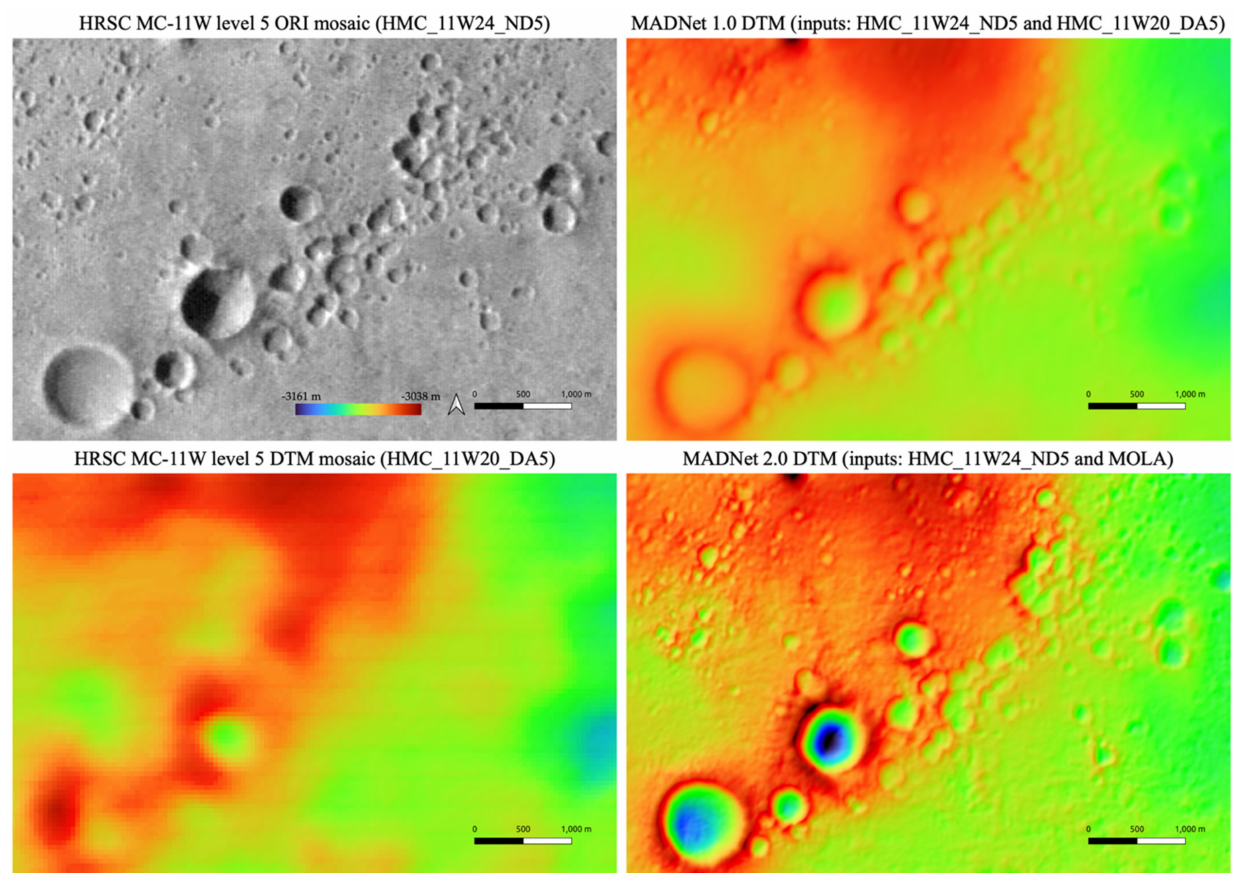
Figure 27. An example of the 12.5 m/pixel MADNet 2.0 HRSC DTM result (using MOLA areoid DTM as the reference), in comparison to the 25 m/pixel MADNet 1.0 HRSC DTM result [7] (using the HRSC MC-11W DTM as the reference) and the 50 m/pixel photogrammetric HRSC MC-11W DTM. This example area is centred at 24.865 ◦ W, 18.385 ◦ N over Oxia